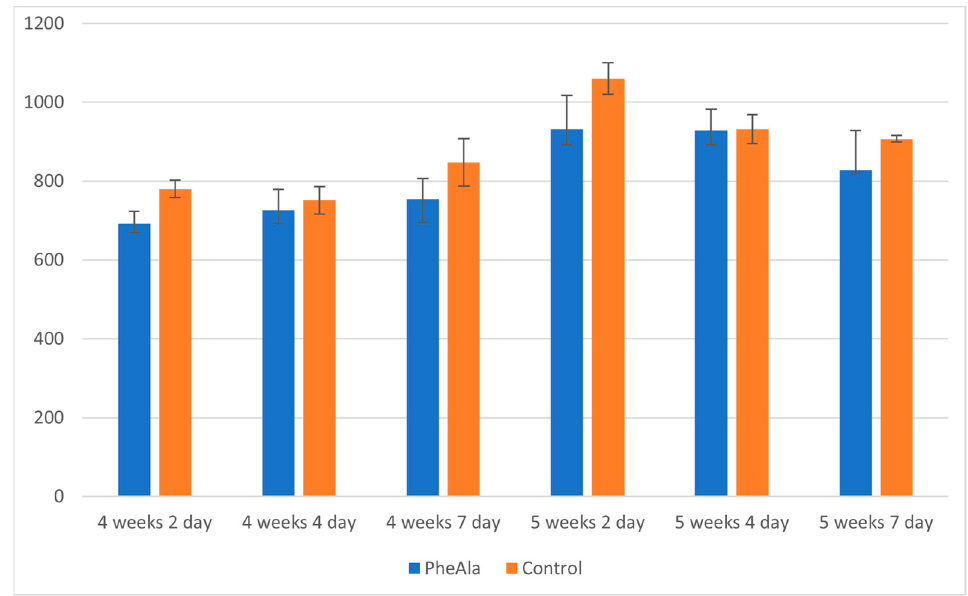
Figure 2. Total content of furanocoumarins in the biomass of R. graveolens agitated shoot cultures (4- and 5-week growth cycle, time after addition of phenylalanine [PheAla]: 2, 4, and 7 days).